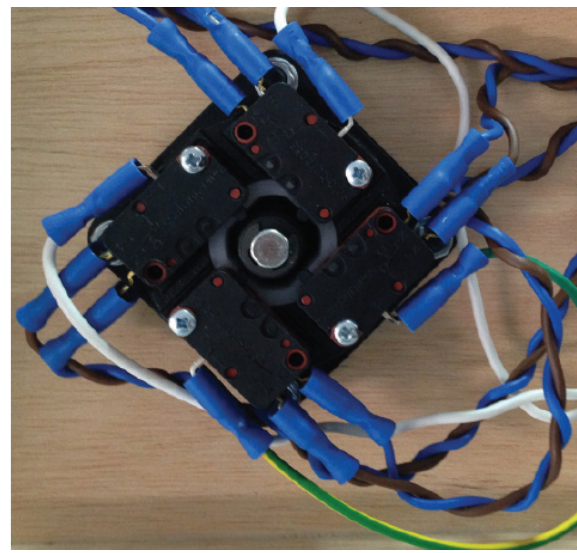
Figure 6. 4 push-buttons of joystick seen from